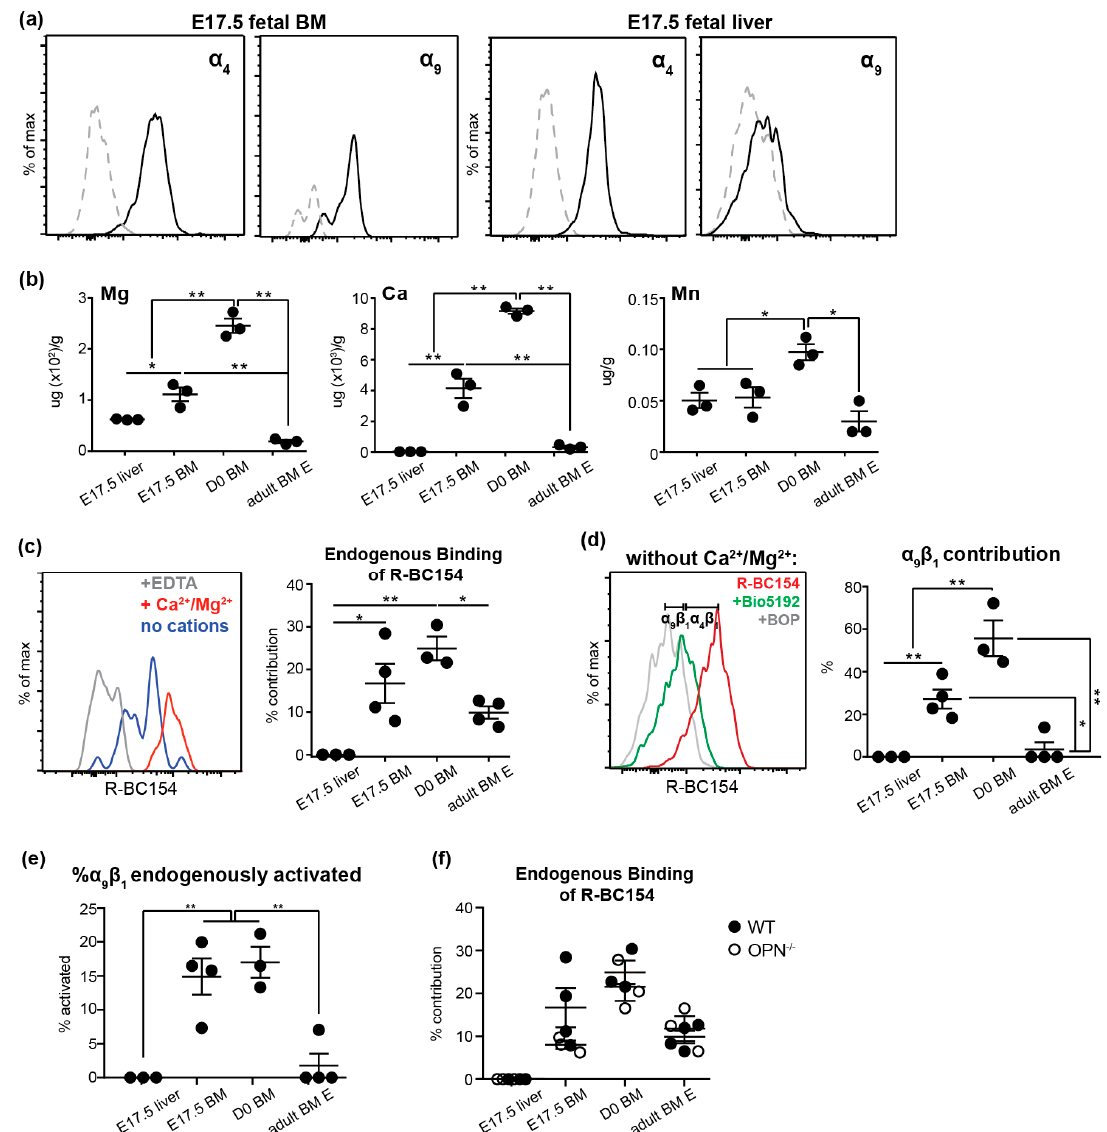
Figure 4 . α 4 β 1 and α 9 β 1 are highly expressed and endogenously activated on fetal BM stem and progenitor cells. ( a ) Representative histograms of α 4 and α 9 (black lines; grey lines, appropriate isotype controls) expression on E17.5 fetal BM and liver LSK cells. ( b ) Quantitative analysis of magnesium, calcium and manganese in fetal liver, fetal BM and adult BM by coupled plasma mass spectrometry (ICPMS). ( c ) A representative histogram of R-BC154 binding to E17.5 fetal BM LSK cells with (red line, maximum binding) or without (blue line, endogenous activation) 1mM Ca 2 + / Mg 2 + , or in the presence of 10mM EDTA to provide the base line (grey) and the endogenous R-BC154 binding during ontogeny was plotted. ( d ) A representative histogram demonstrating the endogenous activation of α 9 β 1 and α 4 β 1 on 17.5 fetal BM LSK cells (red line, combination of endogenous α 9 β 1 and α 4 β 1 activation; difference between grey and green line, α 9 β 1 activation and difference between green and red line, α 4 β 1 activation) and endogenous α 9 β 1 contribution quantified throughout ontogeny. ( e ) The proportion of endogenously activated α 9 β 1 of total α 9 β 1 on 17.5 fetal BM LSK cells. ( f ) Endogenous integrin activation on WT (closed black circles) and OPN -/- (open circles) stem and progenitors during ontogeny. * p < 0.05, ** p < 0.01. Data shows mean ± SEM, n ≥ 3.